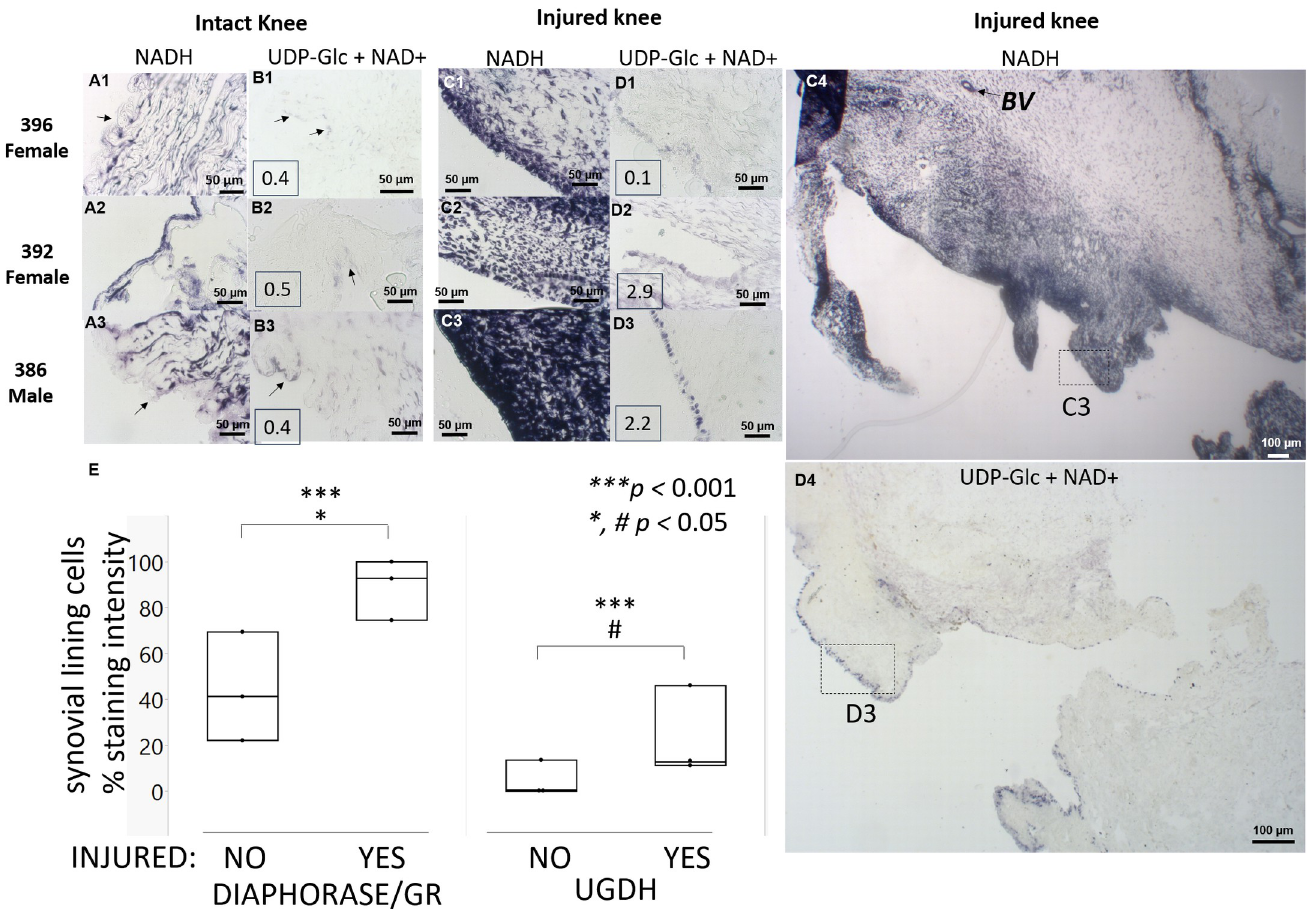
Fig 5. Injured rabbit knee infrapatellar synovium showed higher diaphorase/GR and UGDH activity, and enhanced synovial fluid HA levels in 2 out of 3 rabbit knees compared to contralateral intact knees. Panels show 20x magnification images of synovial membrane from regions with maximal UGDH induction, enzyme stained in situ for diaphorase (A, C), or UGDH (B, D), in intact (A, B) and contralateral injured knees (C, D). Boxed insets in panels B1-3, D1-3 show measured synovial fluid HA levels (mg/mL). (E) Quantitative histomorphometry of % stain (median, min-max, N = 3). Panels C4, D4 show low-magnification image of male rabbit infrapatellar synovium with dotted boxes showing regions illustrated in panels C3 & D3, respectively. Symbols and abbreviations : rabbit ID and sex are shown on the upper left; arrows (A-B) are regions in intact knees where UGDH staining was detected; BV: Blood vessel. Scale bars show 50 μ m or 100 μ m, as